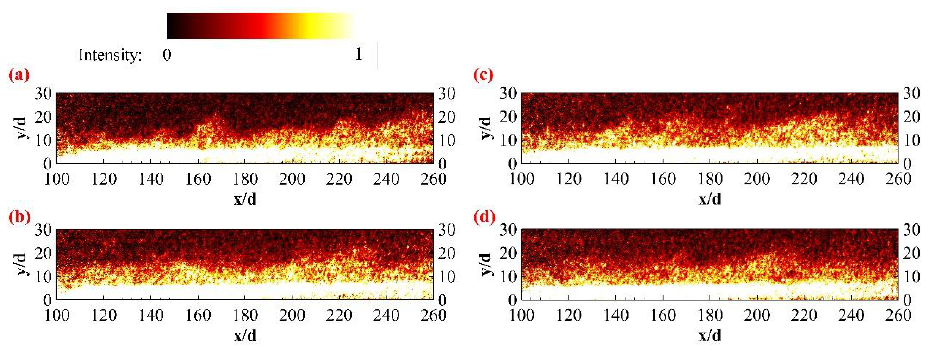
Figure 9. Instantaneous images of fluorescence signal: ( a ) t = 1 s, ( b ) t = 2 s, ( c ) t = 3 s, ( d ) t = 4 s (Test 1-1).